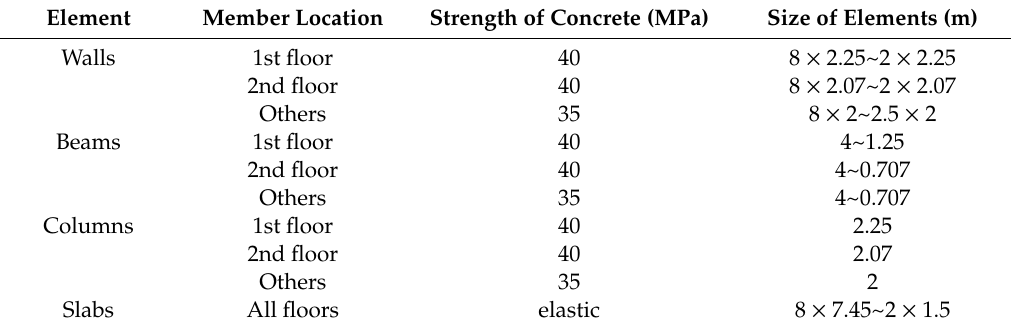
Slabs All floors Note that the sizes of walls mean X -direction / Y -direction × Z